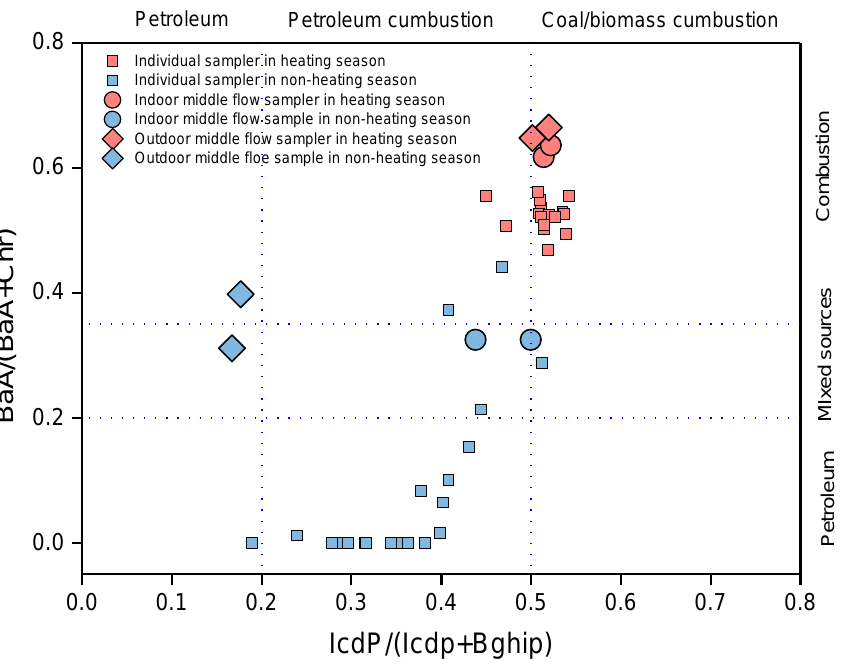
Figure 4. Isomeric ratios of BaA/BaA + Chr versus IcdP/(IcdP + BghiP). The ratios were provided by previous studies [40,43].